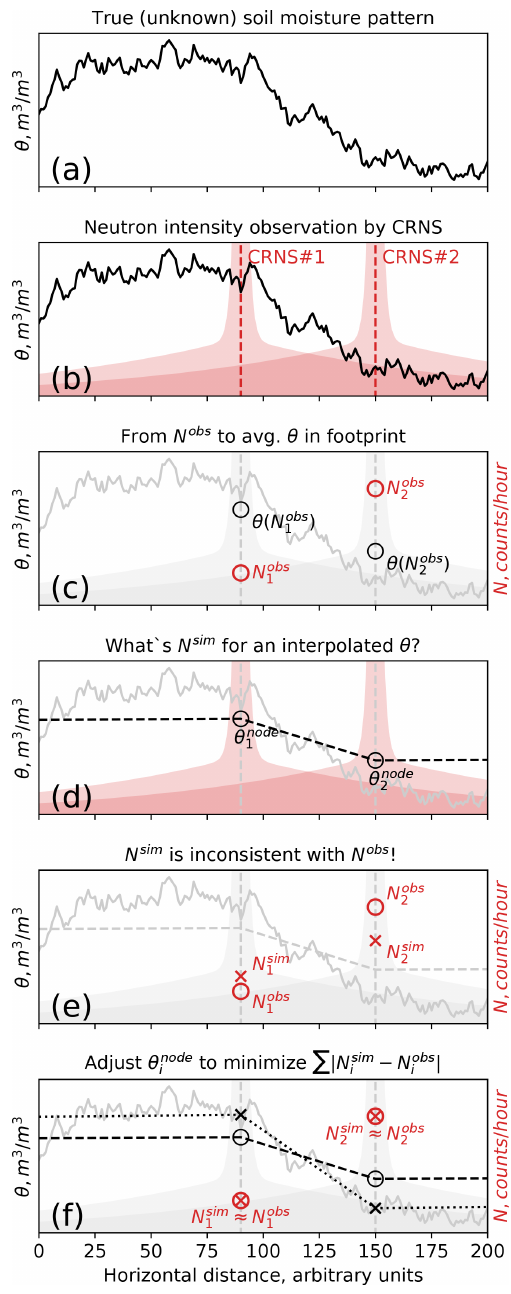
Figure 2. Schematic view of the constrained interpolation model, illustrated by an idealized example with two CRNS sensors and a 1-D horizontal soil moisture distribution. Symbols are explained in the main text; note that the spatial domain extends further to the right but is not shown in full for the sake of